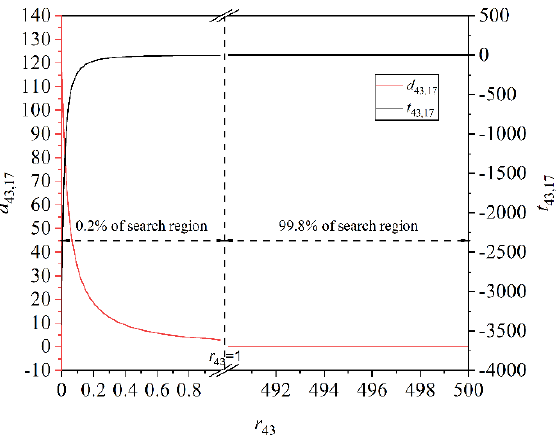
Figure 2. Sensitivity curve of roadway e 43.